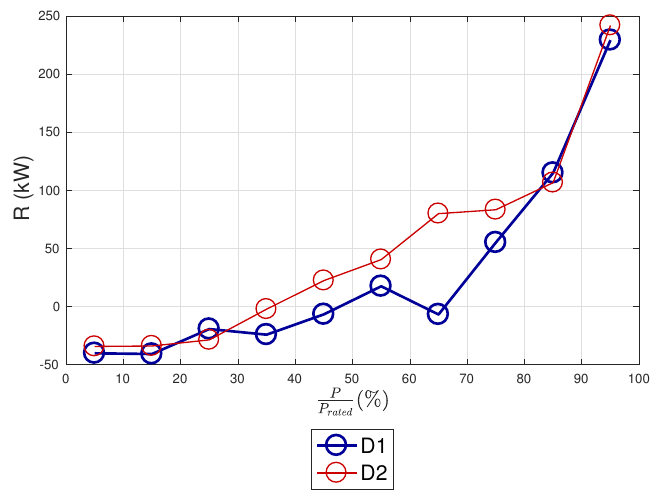
Figure 8. The average difference R between power measurement Y and estimation f ( X ) (Equation (15)). Data sets: D1 and D2. Sample run of the